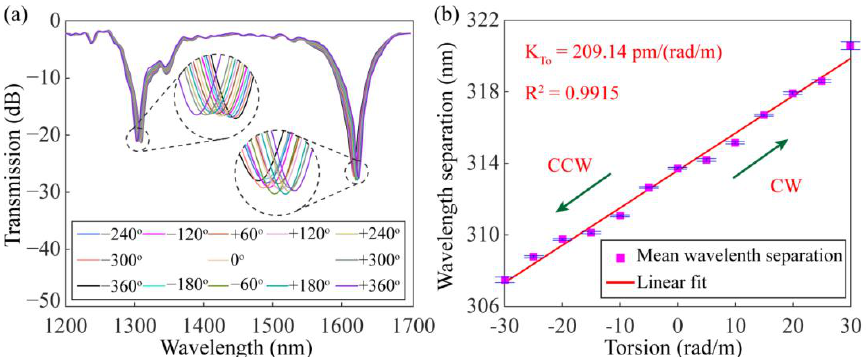
Figure 15. ( a ) Transmission spectra of the dual-resonance SMF-HLPG with different twist angles. ( b ) The dependence of mean wavelength separation on the torsion.